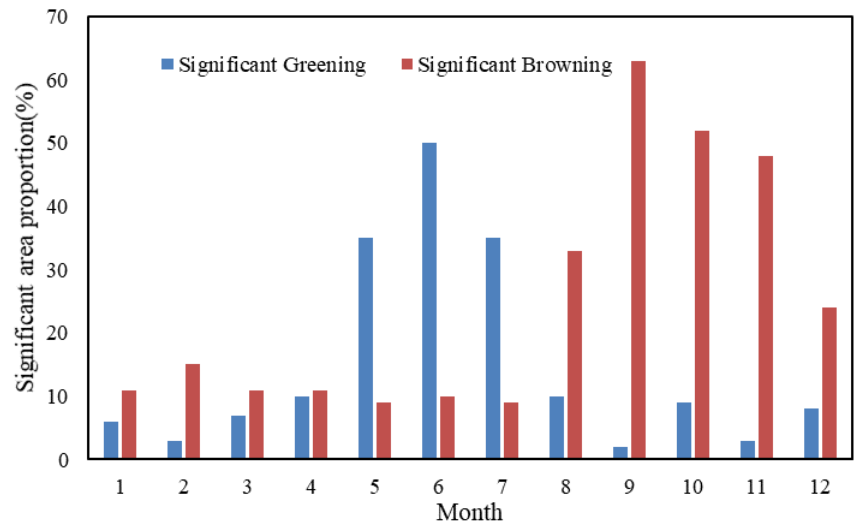
Figure 2. Significant change area proportion of global alpine regions vegetation from 1981 to 2015.